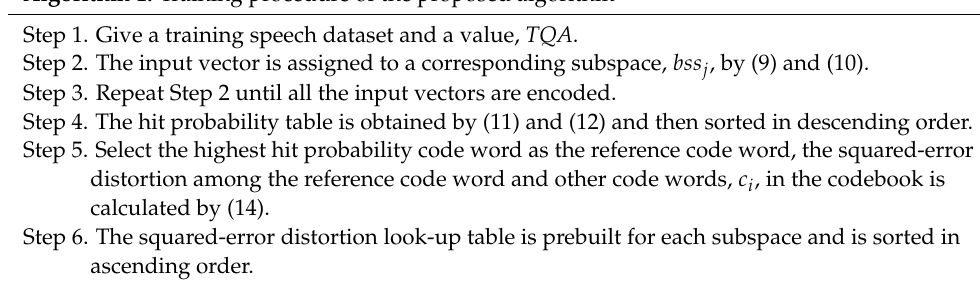
Algorithm 1. Training procedure of the proposed